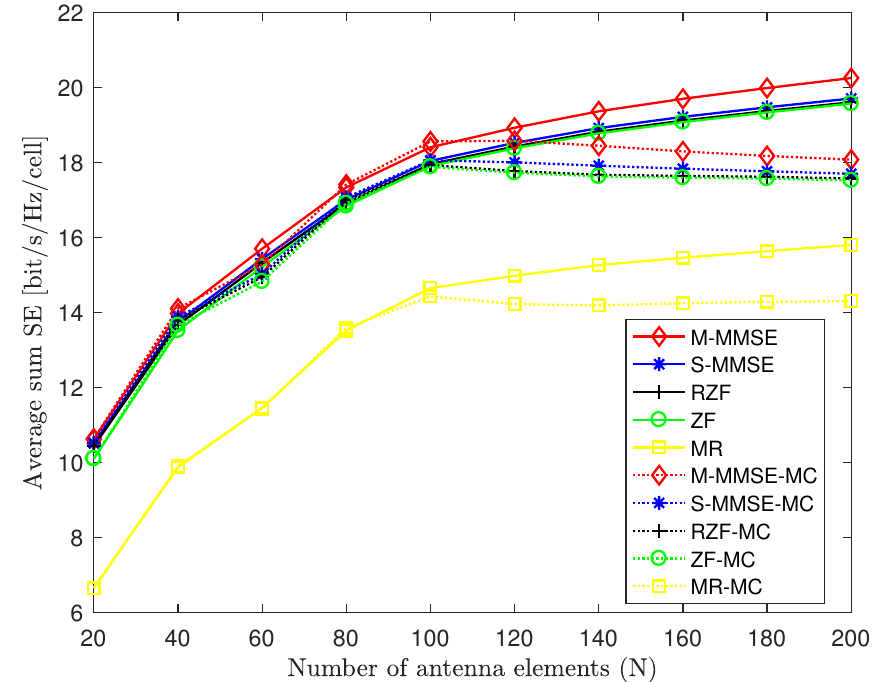
Figure 5. Spectral efficiency comparison of different algorithms with and without mutual coupling vs. inter-element spacing d when the array size is